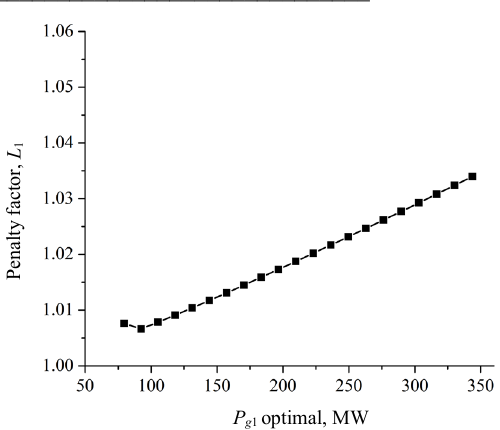
Fig. 6. Power demand vs lambda optimal.